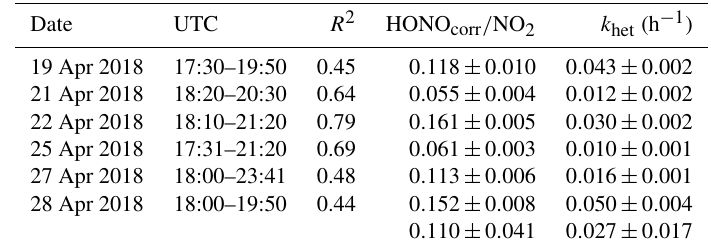
Table 3. The ratio HONO corr / NO 2 and the NO 2 –HONO conversion frequency during early